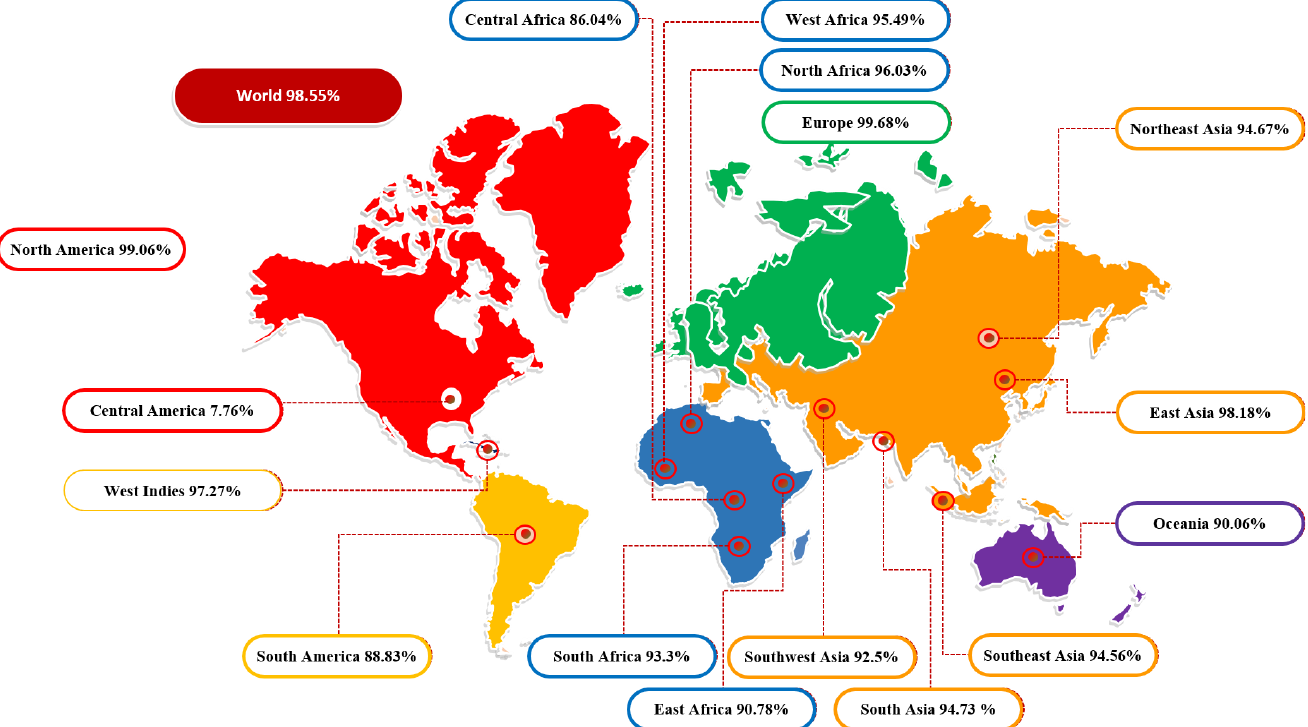
Figure 2. Diagrammatic representation of global population coverage of selected epitopes.